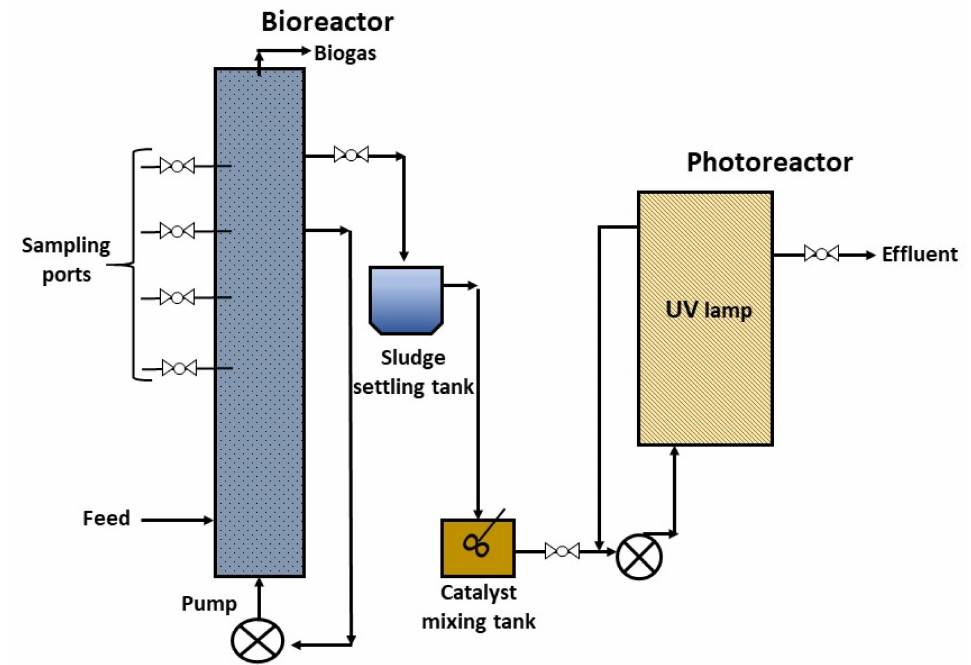
Figure 2. Schematic of coupled anaerobic digestor and photoreactor (modified from Brooms et al. 2020)